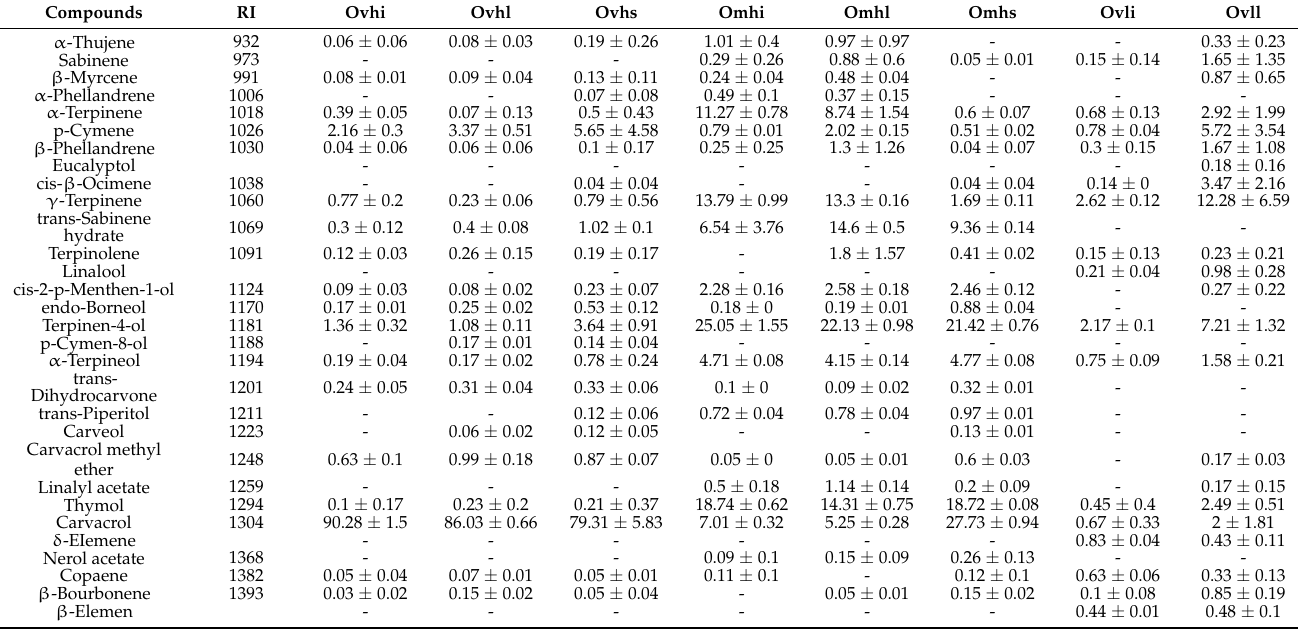
Table 1. Chemical compositions of essential oils derived from the inflorescences, leaves, and stems of three oregano cultivars. Compounds